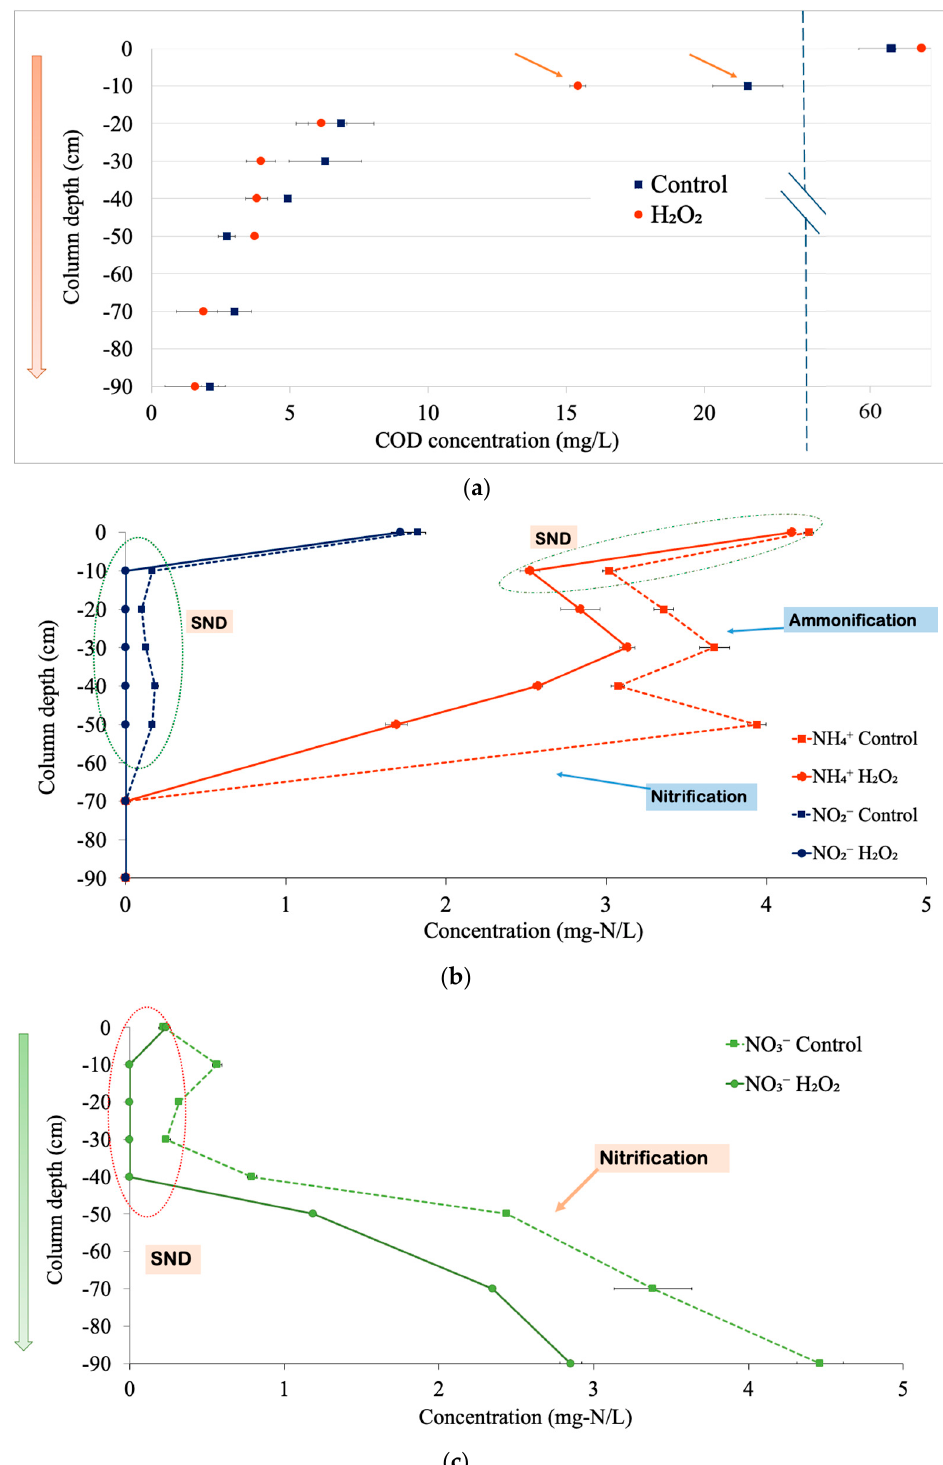
Figure 2. Comparison between the control (RC) and peroxide column (HPC) of the chemical con- centrations’ profiles along depths. ( a ) Comparison of the COD profile (mg/L); ( b ) comparison of the NH 4+ , NO 2 (mg/l-N); and ( c ) NO 3 (mg/l-N) profiles. Standard errors of averaged values are repre- sented by error bars. The suggested dominant nitrogen reactions are noted in highlighted boxes next to the plot lines or highlighted in dotted red circles.